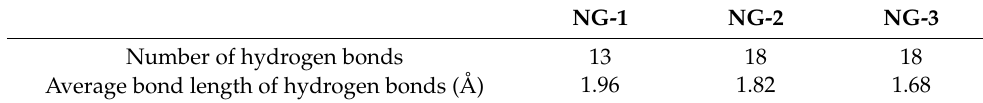
Table 5. Number and average bond length of hydrogen bonds in the three groups of models.